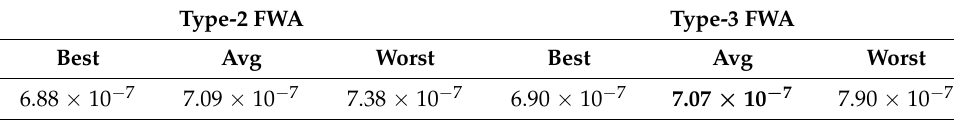
Table 4. First data period (testing prediction, Brazil).